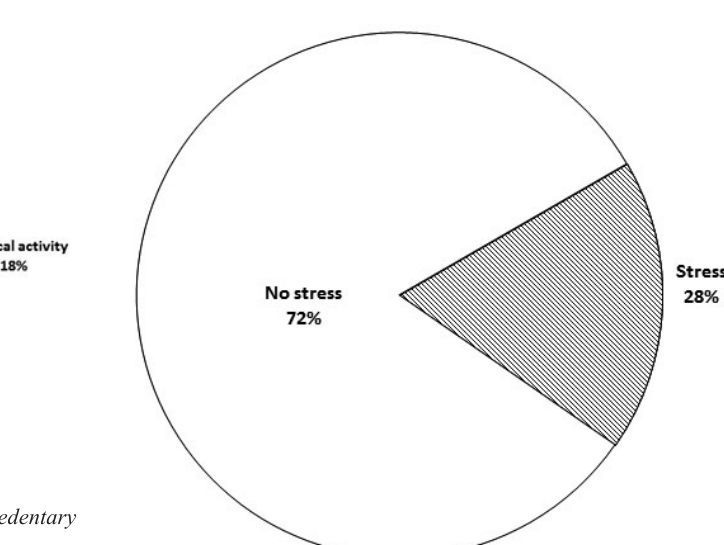
Fig. 3 - Graphic showing that the percentage of the patients presented criteria for inclusion in stress